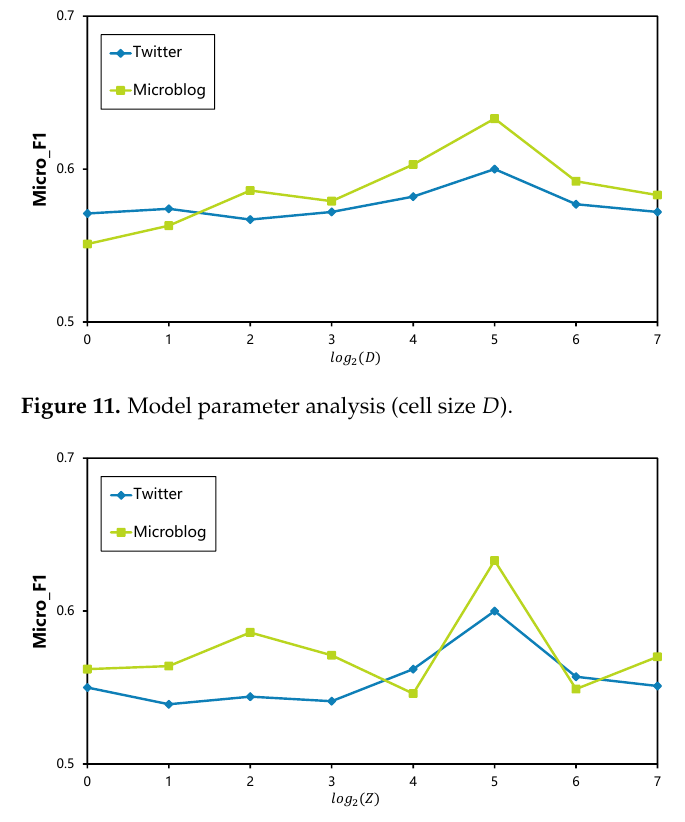
Figure 12. Model parameter analysis (Memory size Z ).